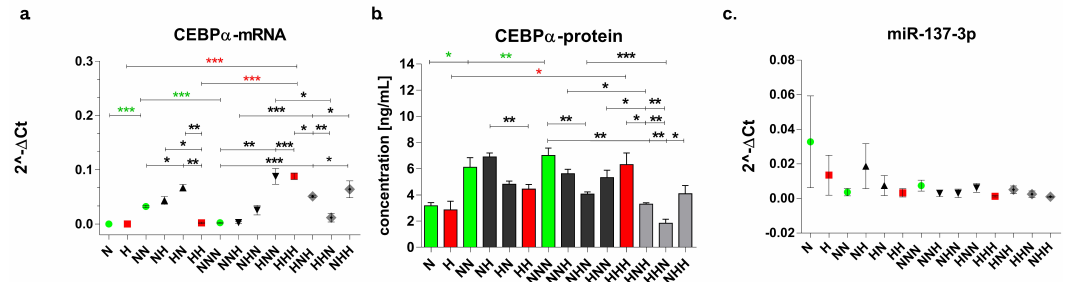
Figure 4. C / EBP α (mRNA and protein) and mir-137-3p expression profile during adipogenesis in chronic / intermittent normoglycemic (N) and hyperglycemic (H) conditions. ( a ) The relative levels of mRNA expression and ( b ) protein concentration of C / EBP α and ( c ) relative levels of miR-137-3p expression evaluated after completion of proliferation, di ff erentiation and maturation of visceral cells. Data are expressed as mean ± SEM. Di ff erences in expression levels between two particular culture variants were evaluated using a two-tailed t-test. One-way ANOVA with a post hoc Tukey test was used for calculation of statistical significance of changes observed during ADG in NG (NN vs N, NNN vs N, NNN vs NN) and HG (HH vs H, HHH vs H, HHH vs HH). *** p ≤ 0.001; ** p ≤ 0.01; * p ≤